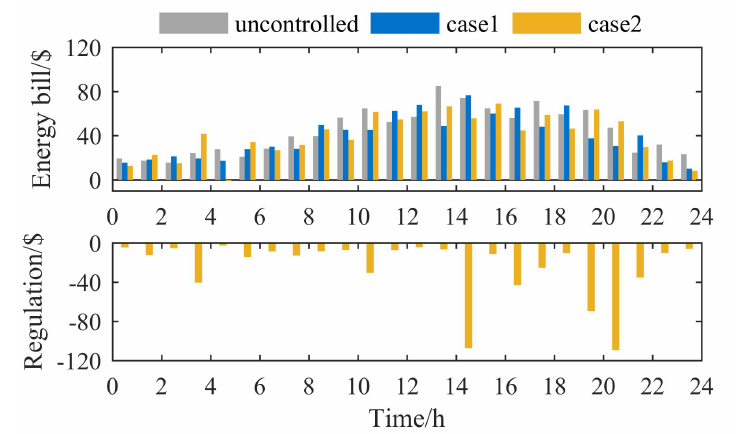
Figure A3. Hourly energy bill and regulation